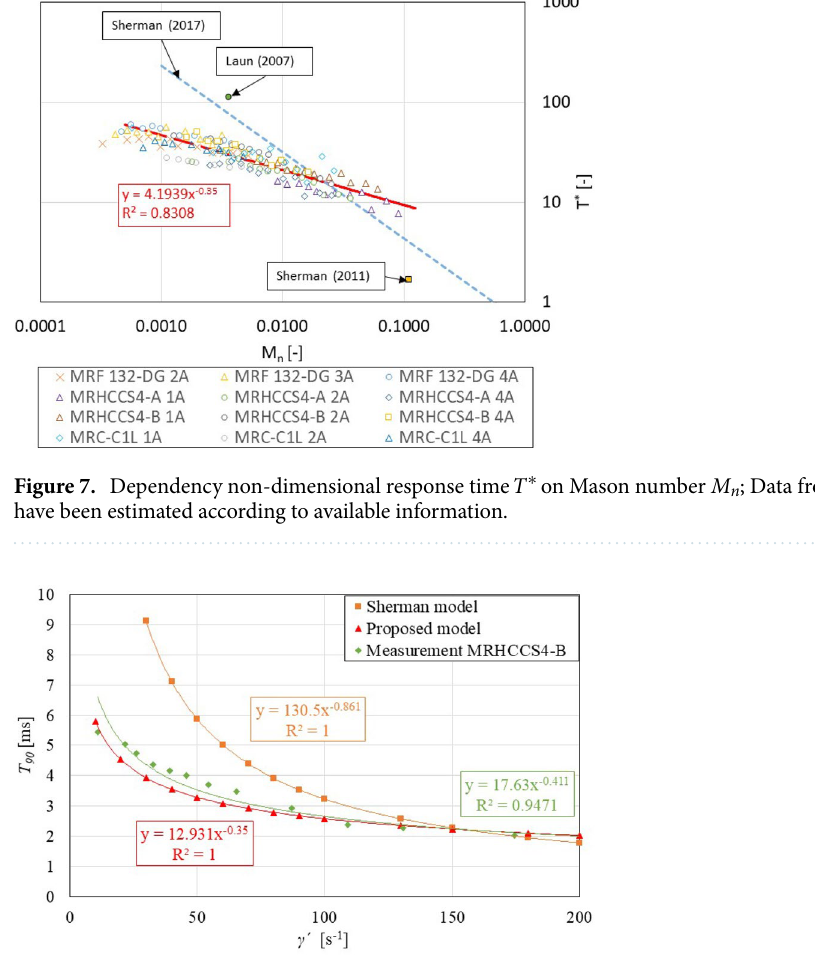
Figure 8. The comparison of model and experiment for the same inputs (MRHCCS4-B, electric current 2